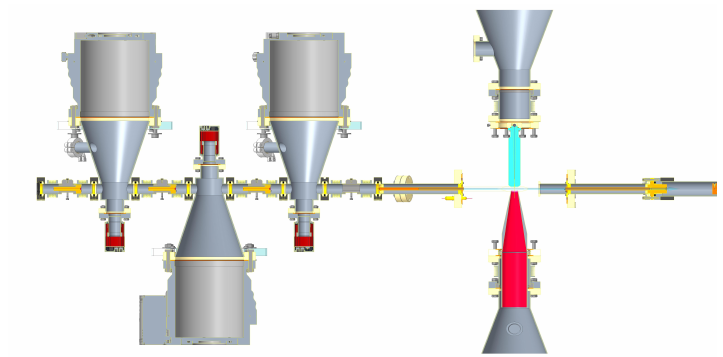
Figure 2. Technical drawing of di ff erential pumping stages. The beam enters at the left and passes through apertures in between the pumping stages, the jet chamber and the static on the most right where it is stopped in a beam calorimeter. The pumping stages are evacuated by three 700 l / s and the jet chamber by a 2300 l / s turbomolecular